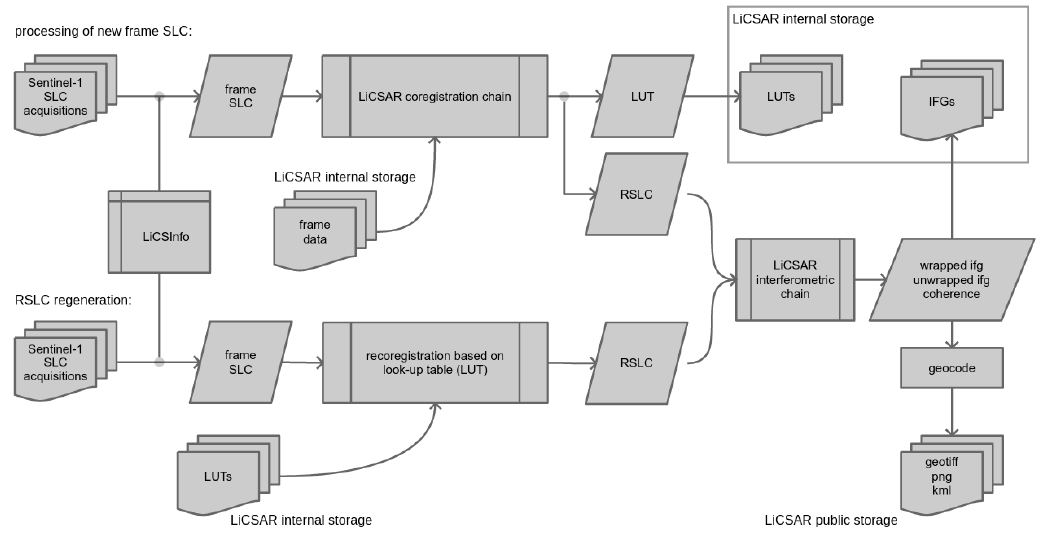
Figure 2. General flowchart of the LiCSAR processing chain.